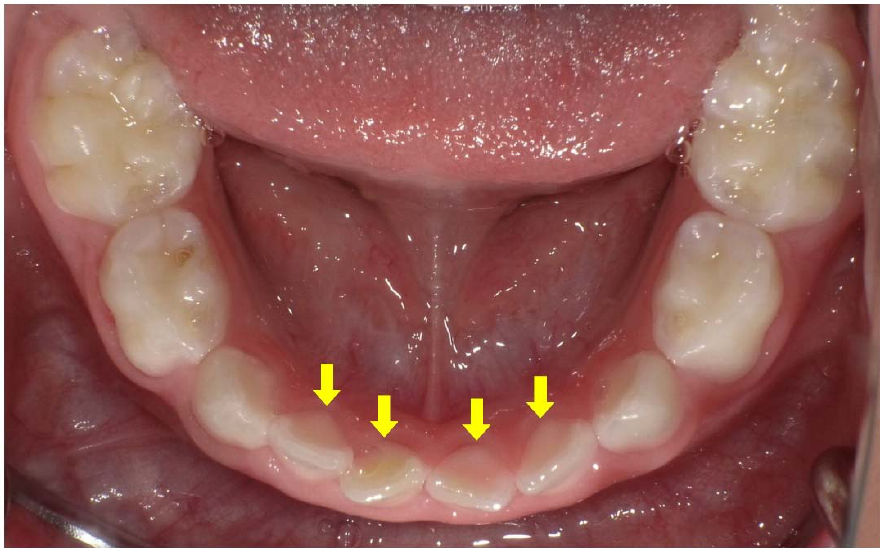
Figure 5. Intraoral photograph of the mandibular arch of a male X-linked hypophosphatemia (XLH) patient aged 3 years 3 months. The pink color of the pulp can be seen through the enamel on the lingual side of the primary mandibular incisors (arrows).